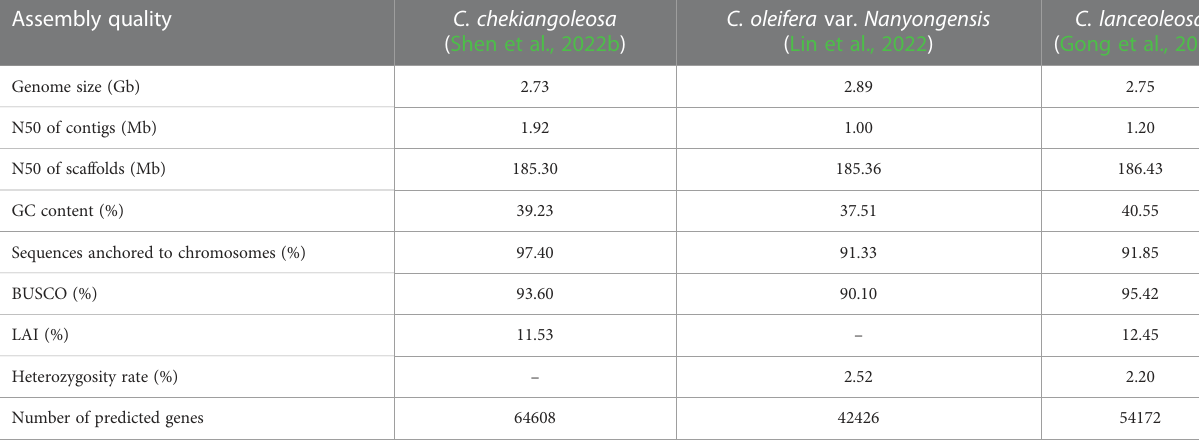
TABLE 1 Comparison of assembled genomes of oiltea-camellia. Assembly